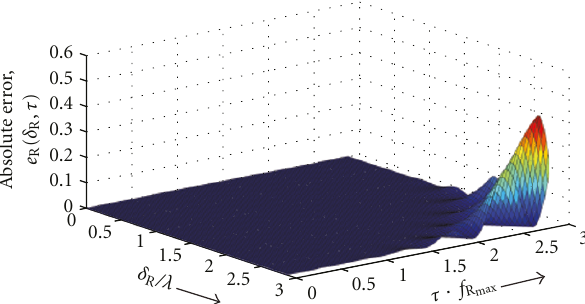
Figure 11: Absolute error e S ( δ S , τ ) = | ρ S ( δ S , τ ) − (cid:22) ρ S ( δ S , τ ) | by using the MMEA with M = 40 (nonisotropic scattering, von Mises = 60 ◦ and κ = 40). density with φ (0) S S